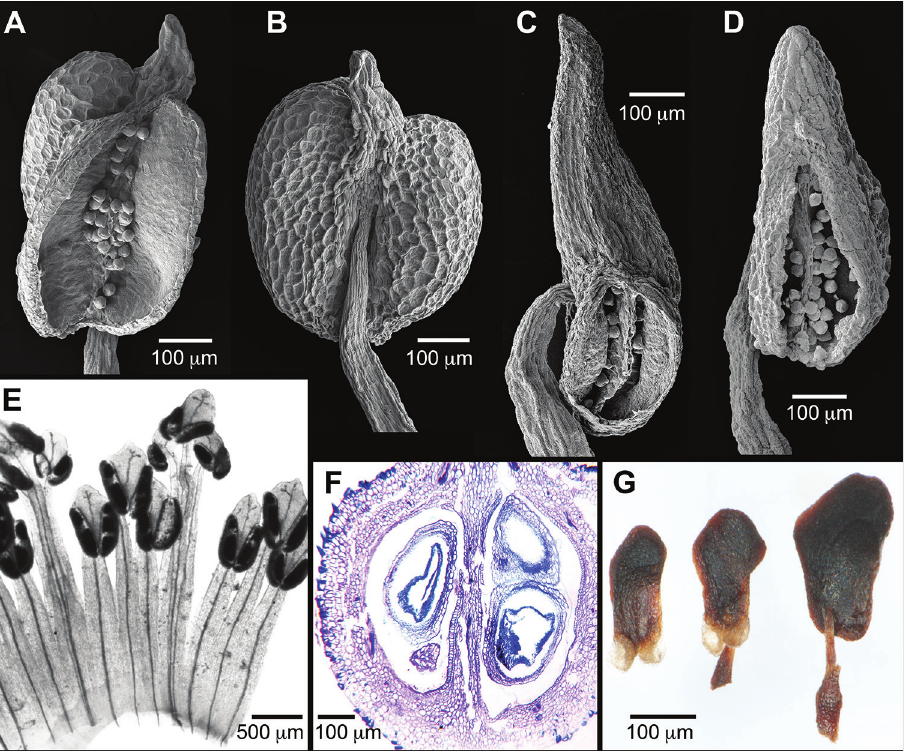
Figure 3 . Stamen structure and anatomy of Humiriaceae. A Vantanea compacta anther, lateral B Vantanea compacta anther, dorsal C Vantanea depleta anther, lateral D Vantanea spiritu-sancti anther, lateral E Schis- tostemon oblongifolius clearing of androecium with 3 stamen types, ventral F Vantanea spiritu-sancti longi- tudinal section of ovary with 2 superposed ovules per locule; lower left ovule partial G Hylocarpa hetero- carpa anthers (left to right): disporangiate dorsal, ventral; sterile, dorsal. Sources: A, B Hatschbach 21265 C Hammel & Trainer 12954 D, F Silva et al. 1436 E Maas et al. 6804 G Ducke [JBRJ-30137] (all